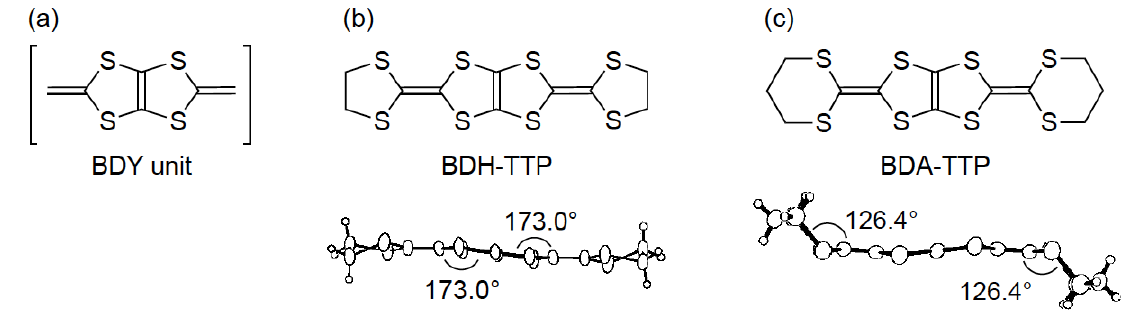
Figure 2. ( a ) Bis(1,3-dithiol-2-ylidene) (BDY) unit. Molecular structures of ( b ) 2,5-bis(1,3-dithiolan-2-ylidene)-1,3,4,6-tetrathiapentalene (BDH-TTP) and ( c ) 2,5-bis(1,3-dithian-2-ylidene)-1,3,4,6-tetrathiapentalene